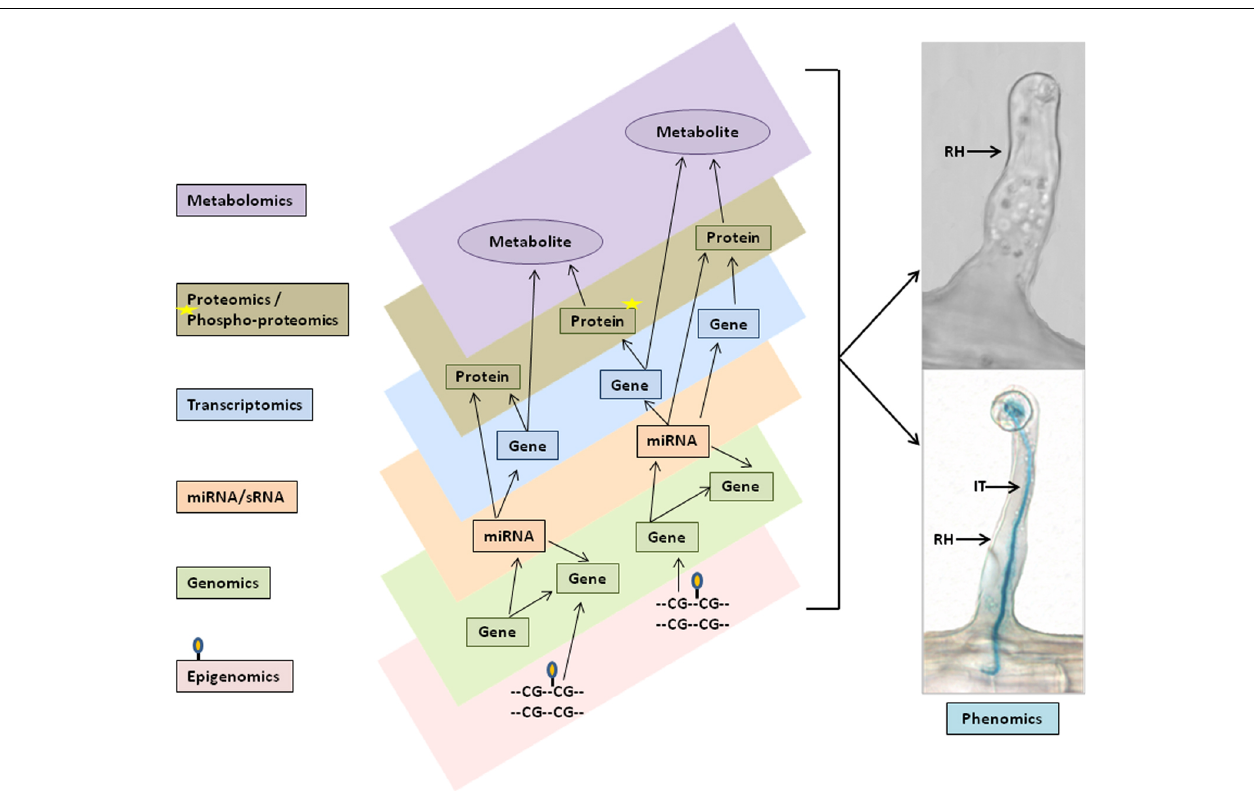
FIGURE 2 | Schematic representation of multi- omics data integration and networks for single cell phenomic studies. Varieties of multi-omics data set, such as genomics and epigenomics (i.e., DNA methylation), miRNAs/sRNAs, transcriptomics, proteomics and phosphoproteomics, and metabolomics (left flow chart) were generated